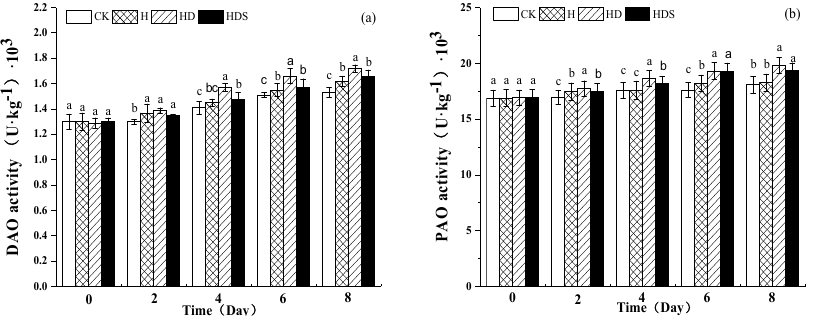
Figure 7. Effects of exogenous spermidine and D-arg on the activities of DAO ( a ) and PAO ( b ) in lettuce under high-temperature stress. Vertical bars represent standard deviations of the mean ( n = 3). Values above each vertical bar followed by different letters show significant differences ( p < 0.05). CK, 22 ◦ C/17 ◦ C, deionized water; H, 35 ◦ C/30 ◦ C, deionized water; HD, 35 ◦ C/30 ◦ C, 1 mM D-arg; HDS, 1 mM D-arg+ 1 mM